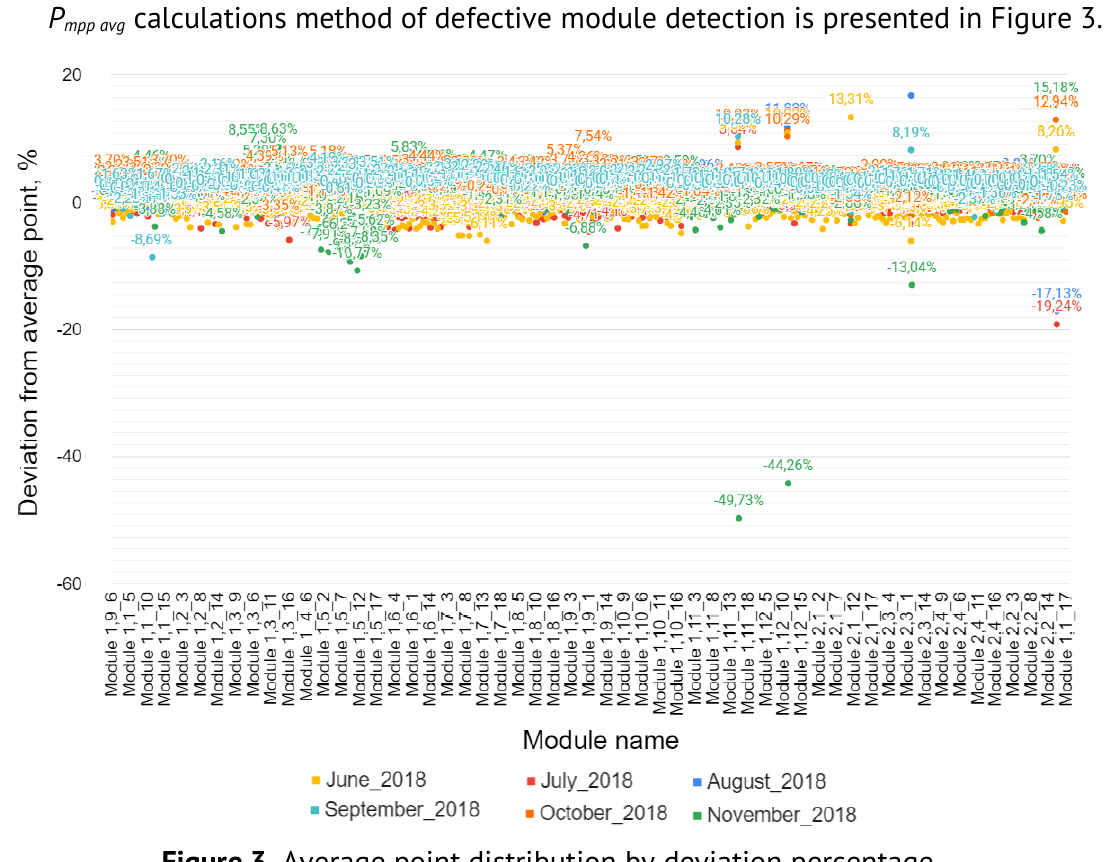
Figure 3. Average point distribution by deviation